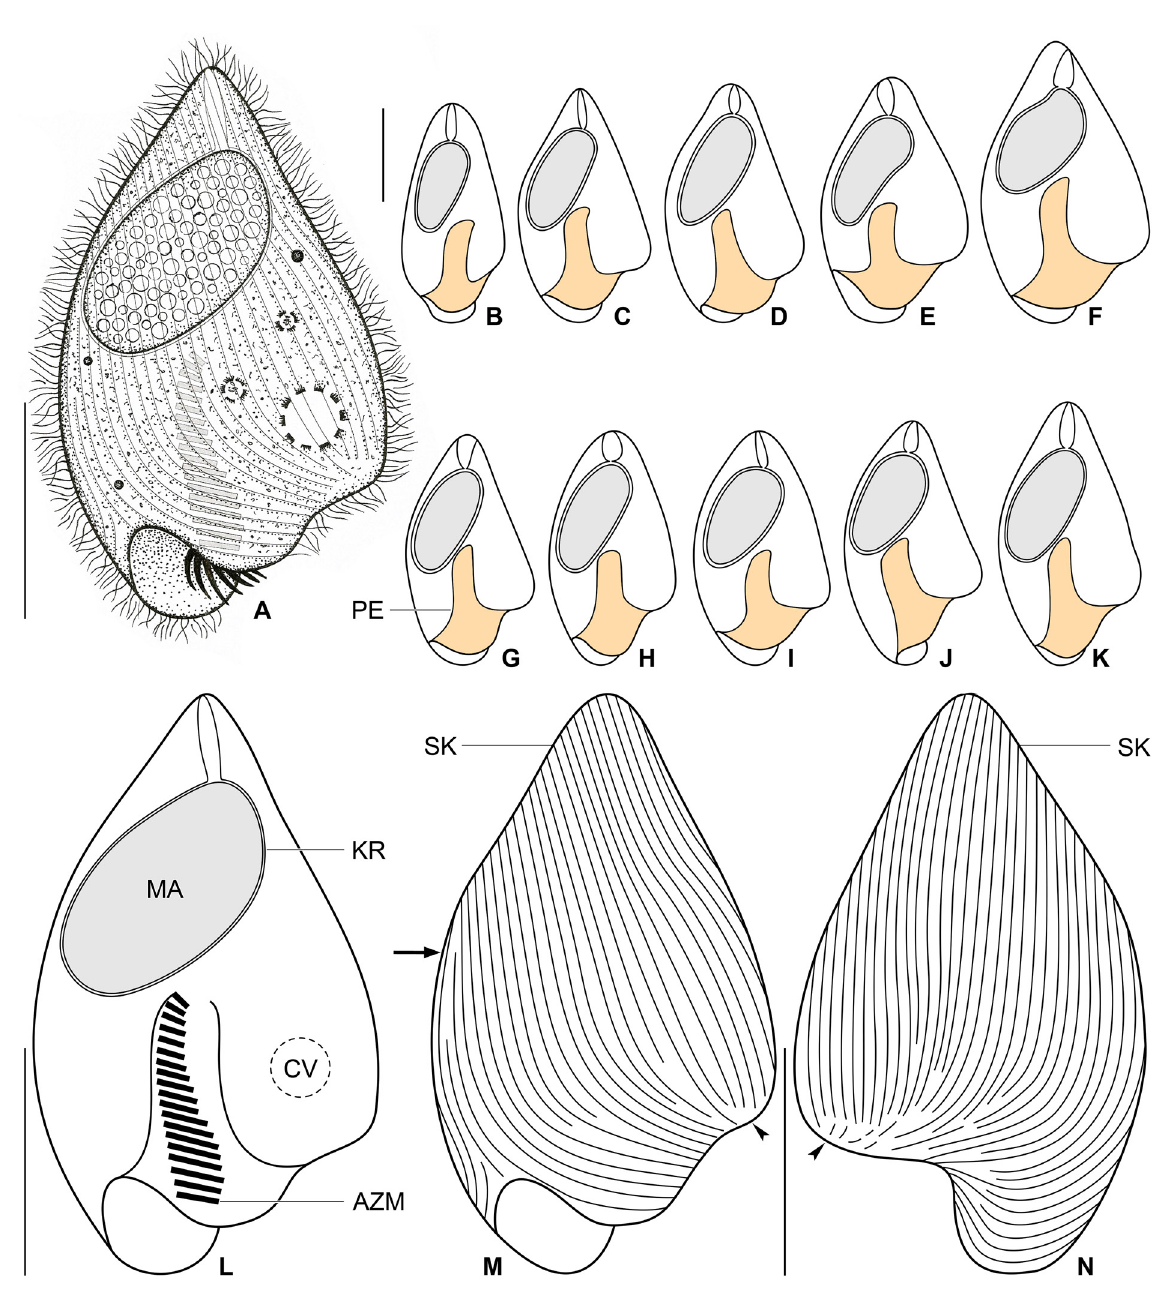
Fig. 12. Paraclevelandia brevis Kidder, 1937. Vietnamese specimens isolated from Panesthia angustipennis cognata Bey-Bienko, 1969 from life (A) and after protargol impregnation (B–N). A . Ventral view of a representative specimen, length 50 μm. B–K . Variability of body shape and size as well as of the nuclear (shaded grey) and oral (shaded yellow) apparatus. L . Semi-schematic diagram, showing the general body organization. M–N . Ciliary pattern of ventral and dorsal sides. Arrow marks the right suture, black arrowheads indicate the position of the ciliary whorl (posterior suture). Scale bars = 20